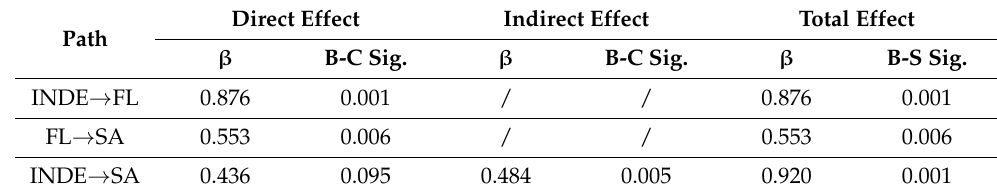
Table 12. Direct and indirect effects.